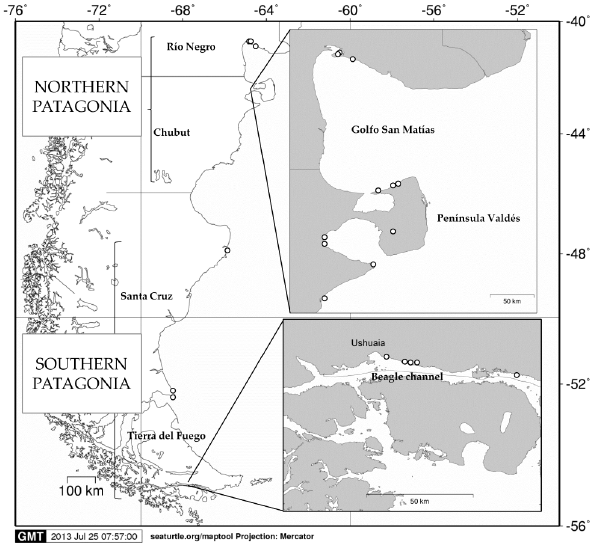
Figure 1. Study areas (central-northern Patagonia and south- ern Patagonia) and sampling approximate zones. Empty dots represent archaeological sites.